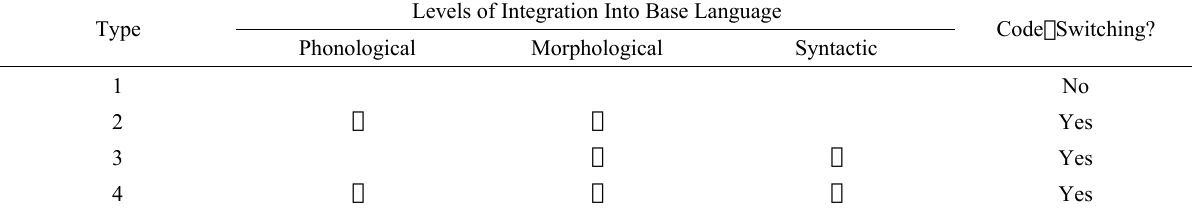
Poplack’s (1980) Identification of Code - Switching Based on the Type of Integration into the Base Language Levels of Integration Into Base Language Type Phonological Morphological